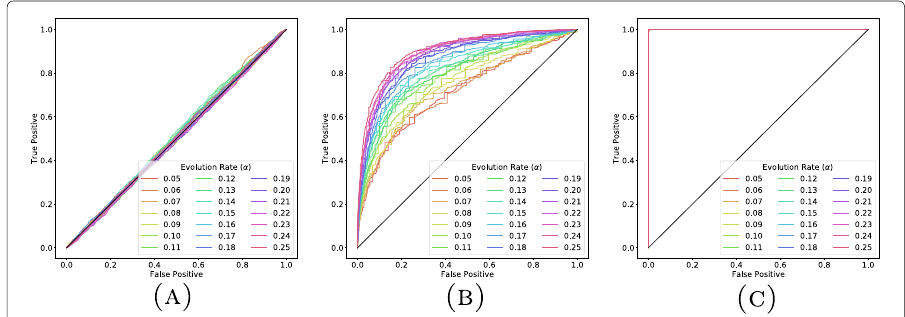
Fig. 5 Power-Law Distribution, Scan, 10 edges. a Kolmogorov-Smirnov. b Relative Hausdorff. c